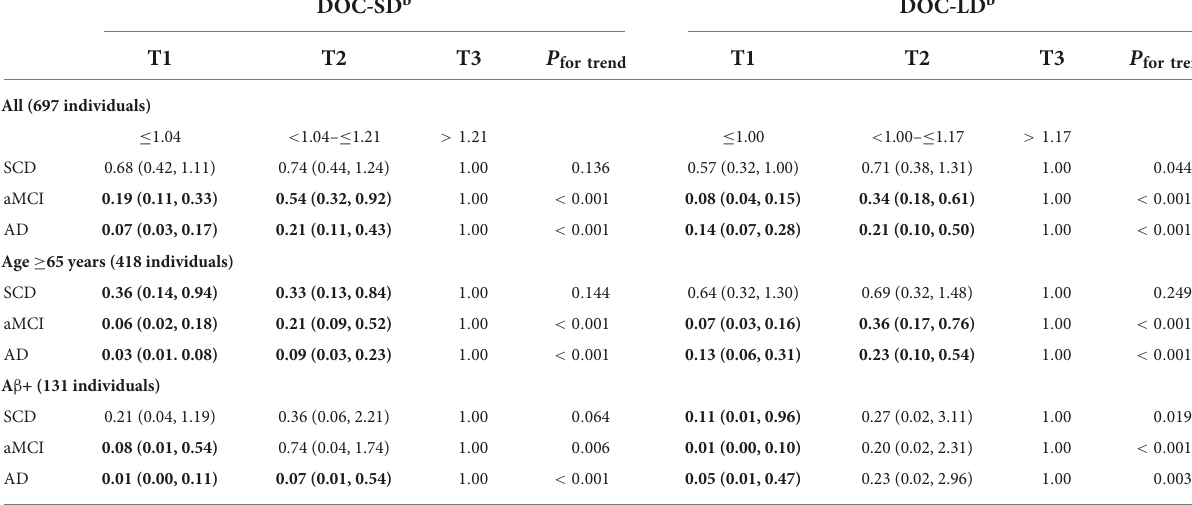
TABLE 3 Multivariate logistic regression and adjusted odds ratios (95% CIs) of participants with different cognition groups a